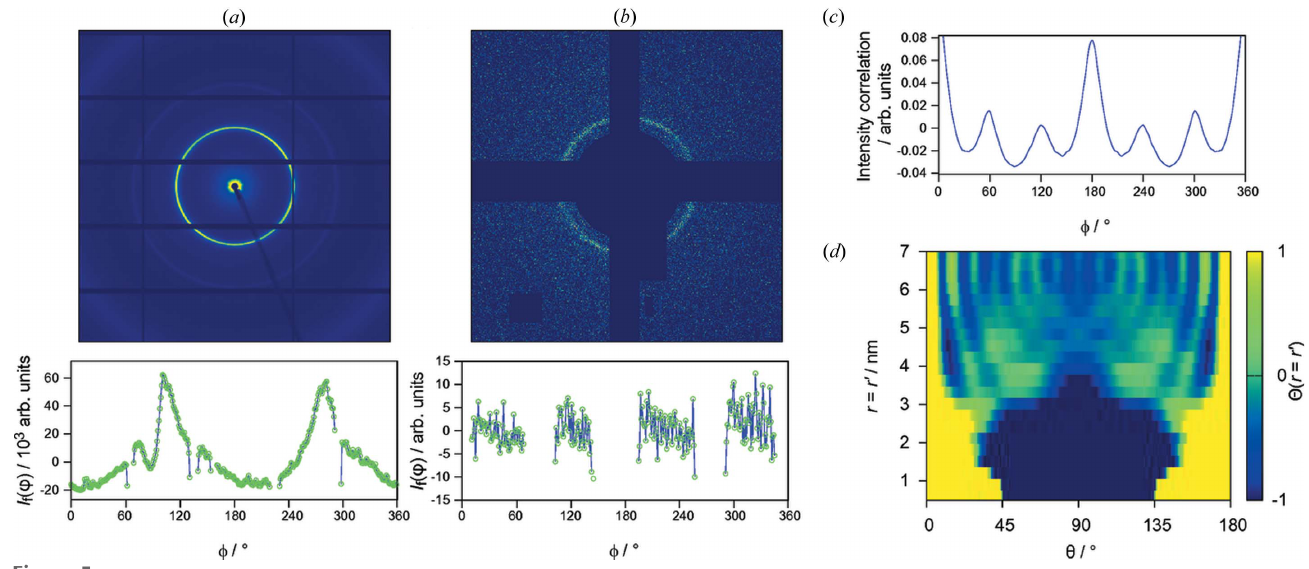
Figure 5 Emergence of nanoscale features. Typical diffraction patterns from CTAB–H 2 O (40 mol% CTAB) hexagonal mesophases data collected with ( a ) a 25 (cid:5) 250 m m SAXS beam and ( b ) a 4 (cid:5) 4 m m XFM beam. Profiles indicate the intensity fluctuations ( i.e. relative to the mean) around the (10) diffraction peak. Omitted regions are covered by detector masks. ( c ) Angular correlations of the (10) diffraction ring from XFM data showing clear peaks at n (cid:3) /3; ( d ) r = r 0 slice through the data collected at the XFM beamline. Nanoscale structural features can be observed below 6